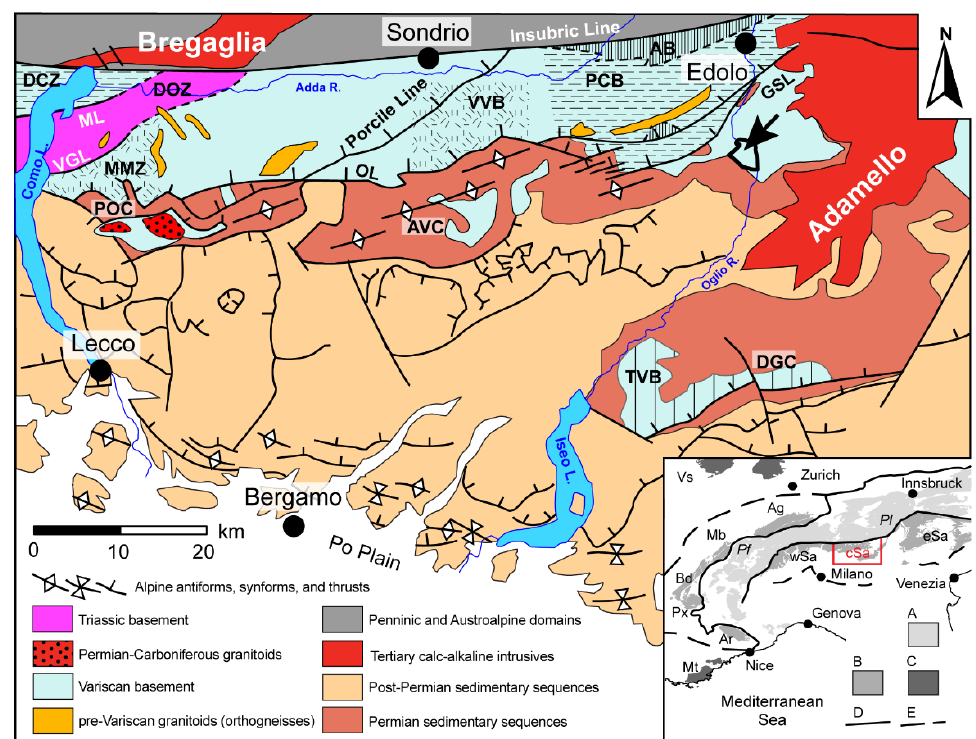
Figure 2. Geologic sketch of the central Southalpine domain modified from [49] and refs. therein. The present study area is shown as a black polygon indicated by a black arrow (cfr. Figure 3). Variscan Tectono–Metamorphic Units: AB = Aprica Basement; DCZ = Domaso—Cortafò Zone; DOZ = Dervio—Olgiasca Zone; MMZ = Monte Muggio Zone; PCB = Passo Cavalcafiche Basement; TVB = Tre Valli Bresciane massif; VVB = Val Vedello Basement. Permian conglomerates with pebbles deriving from the Variscan TMUs: POC = Ponteranica Formation; AVC = Aga and Vedello Conglomerates; DGC = Dosso dei Galli Conglomerate. Main tectonic lines: GSL = Gallinera e Sellero Lines; ML = Musso Line; OL = Orobic Line; VGL = Val Grande Line. Inset with the tectonic sketch of the Alps after [78]. A = Variscan basement rocks in the Alpine subduction complex; B = Variscan basement rocks in the Alpine external domains (Ag: Aar–Gotthard Massif, Ar: Argentera–Mercantour Massif, Bd: Belledonne Massif, Mb: Mont Blanc Massif, Px: Pelvoux Massif, wSa: western Southern Alps, cSa: central Southern Alps, eSa: eastern Southern Alps); C = Variscan basement rocks external to the Alpine fronts (Mt: Maures–Tanneron Massif, Vs: Vosges); D = lithospheric-scale structures delimiting the axial zone of the Alps (Pf: Penninic Front, Pl: Periadriatic Lineament); E: Alpine fronts.